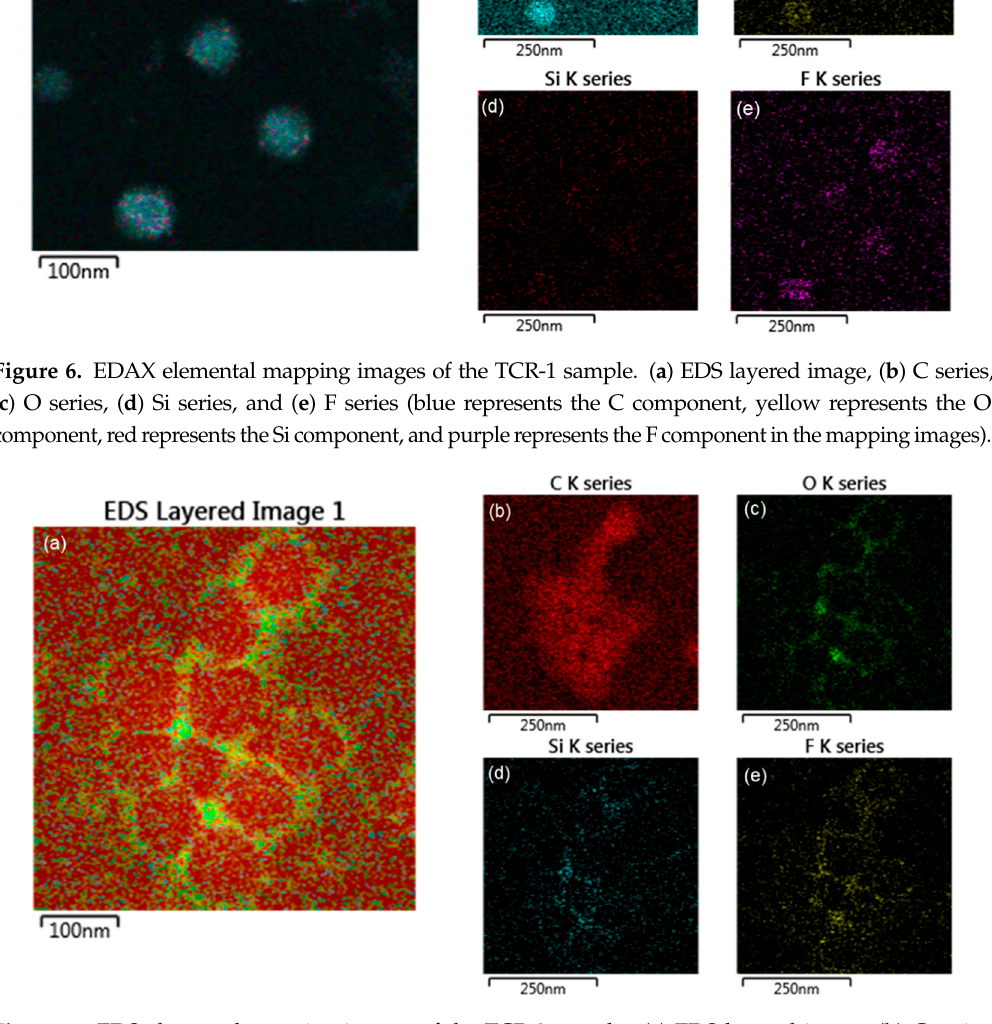
Figure 7. EDS elemental mapping images of the TCR-2 sample. ( a ) EDS layered image, ( b ) C series, ( c ) O series, ( d ) Si series, and ( e ) F series (red represents the C component, green represents the O component, blue represents the Si component, and yellow represents the F component in the mapping images).